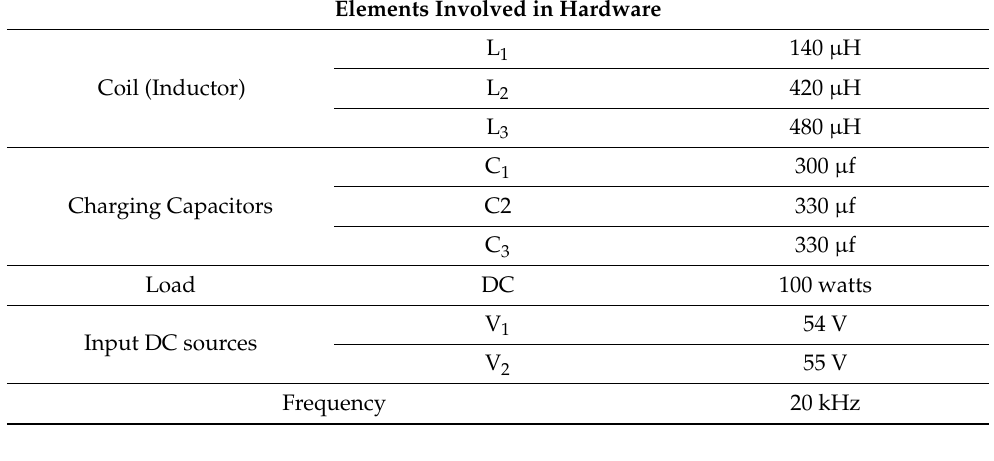
Table 5. Hardware component values.